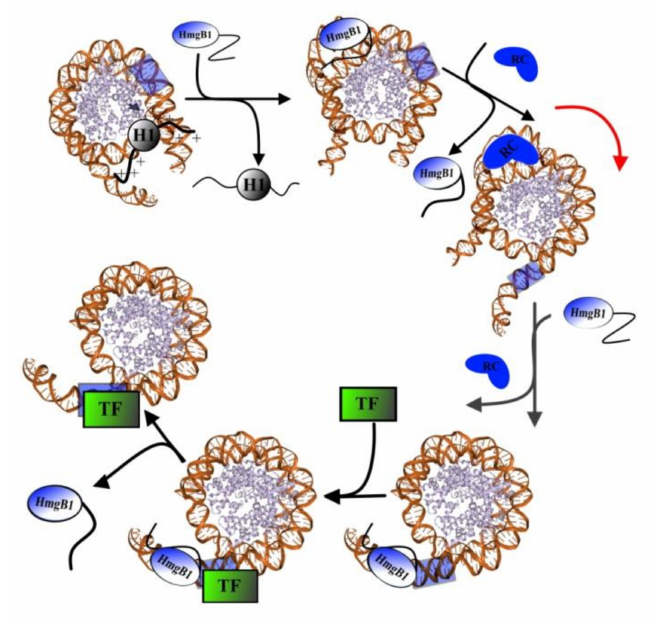
Figure 3. The model of the sliding of nucleosome along the DNA. According to this model, the binding of HmgB1 with H1 histone results in disruption of H1 interactions with DNA and its displacement. The loops of DNA formed by HmgB1-DNA binding are necessary for interaction of the remodeling complex (RC) with DNA. In turn, PC–DNA complex is responsible for the sliding of the nucleosome, until the transcribed region of DNA becomes available for transcription factors (TF). Next, the process of HmgB1-dependent binding of transcription factors to DNA takes